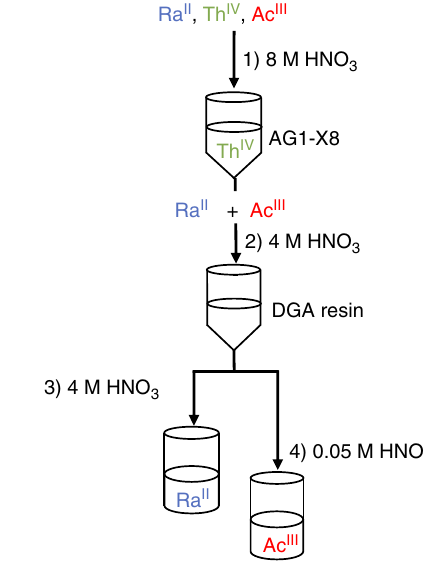
Figure 6 | Cartoon describing 227 Ac radiochemical purification. Scheme showing the procedure followed to separate 227 Ac from its daughters 229 Th and 223 Ra using anion exchange resin and DGA resin,